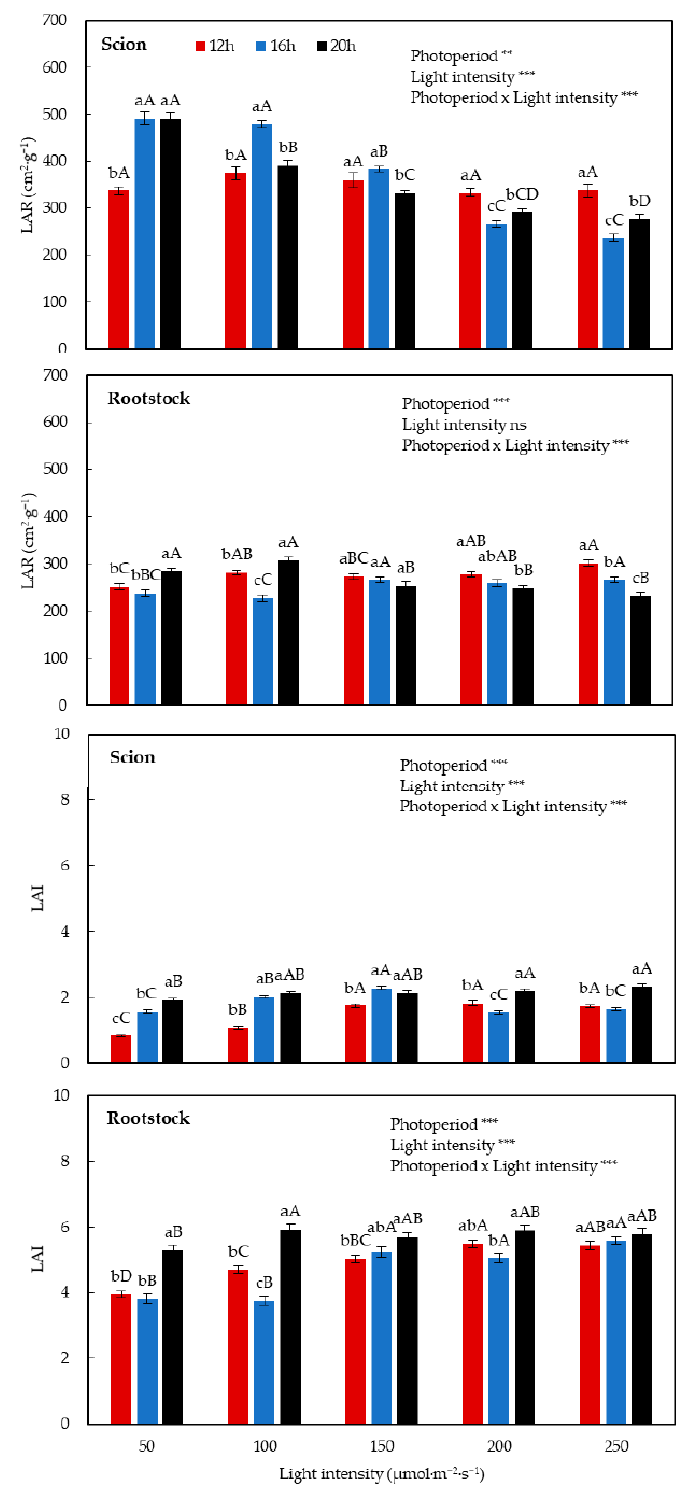
Figure 10. Leaf area ratio (LAR) and leaf area index (LAI) of cucumber scions and rootstocks as affected by the different photoperiod and light intensity treatments in a PFAL. The error bar indicates the standard error of the mean for 3 replicates with 7 samples. **, *** and ‘ns’ indicate significant differences at p < 0.01, 0.001 and non-significant differences, respectively. Values with different letters differ significantly at the 95% level according to Tukey’s HSD test. Lowercase letters compares photoperiod treatments for each light intensity treatment. Uppercase letters compare light intensity treatments for each photoperiod